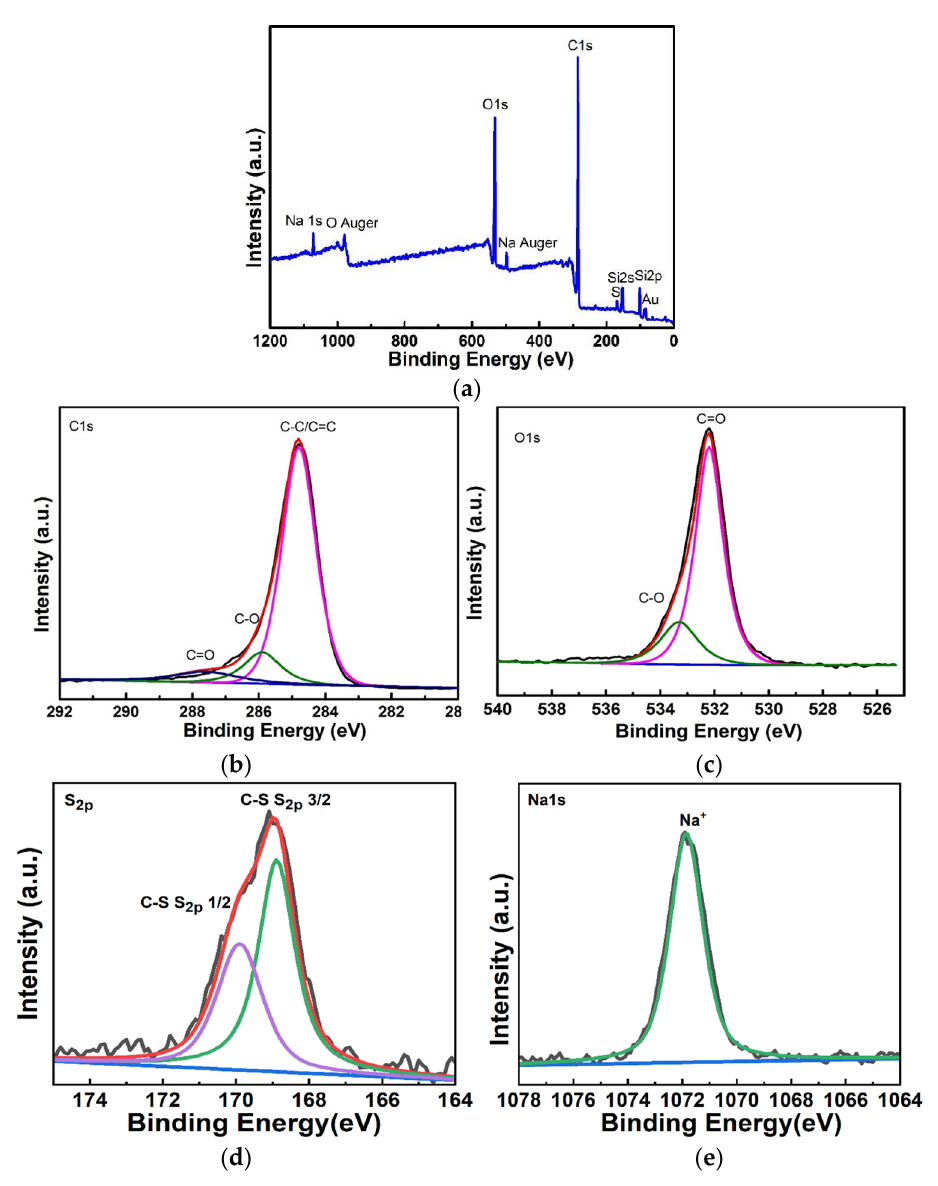
Figure 9. ( a ) The full spectrum of the XPS of the rGO-SDS composite film. ( b , c ) XPS fine spectrum of element C and O of rGO-SDS composite film. ( d , e ) XPS fine spectrum of element S and Na of rGO-SDS composite film.